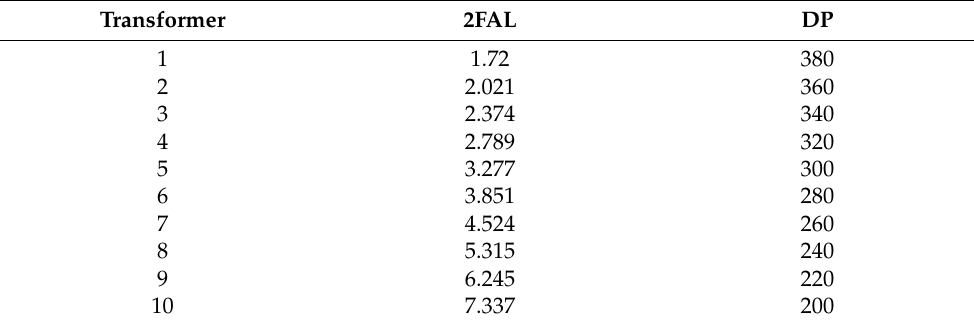
Table 2. Transformer case